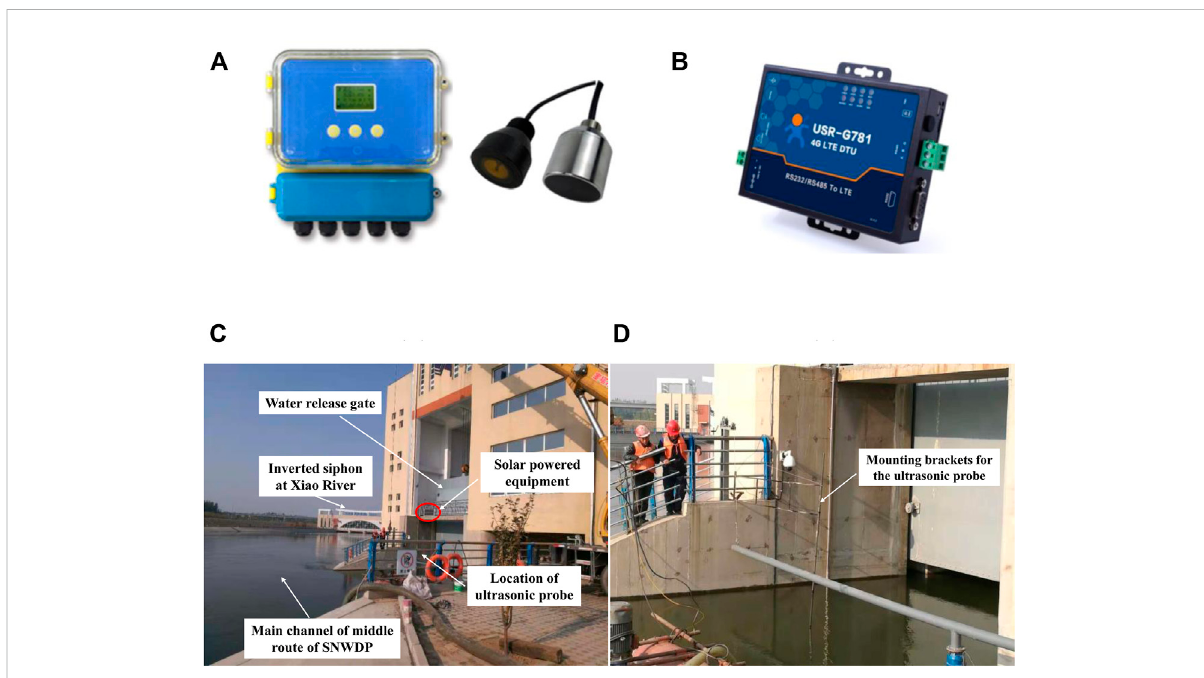
Figure 3B) and the 4G mobile phone signal network. The